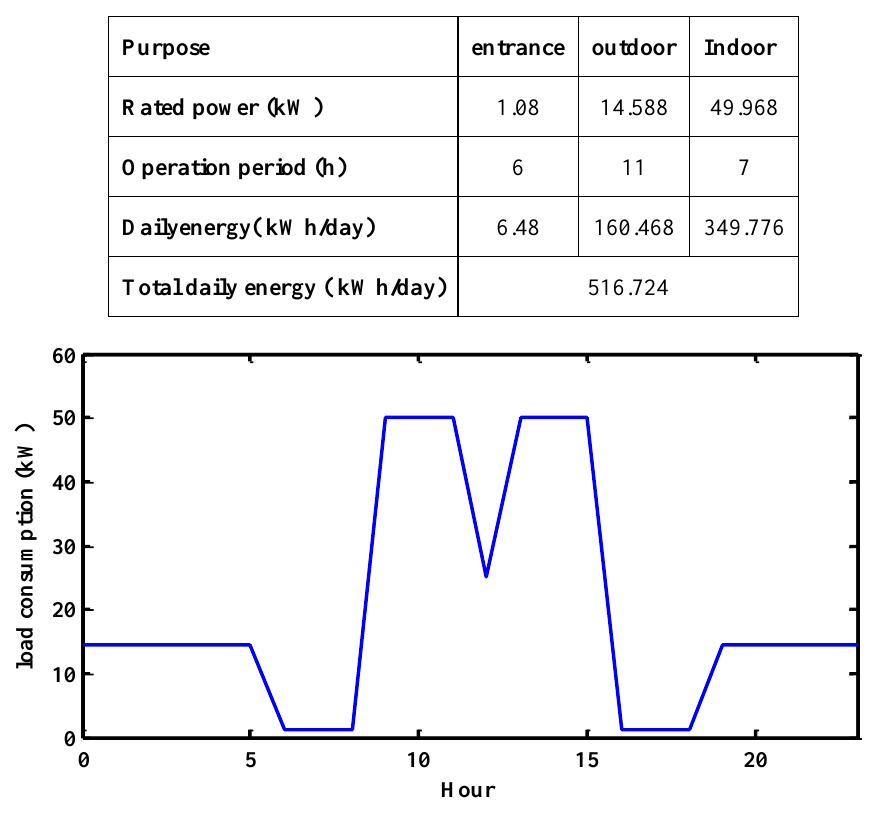
Table 2. Daily electrical load requirements